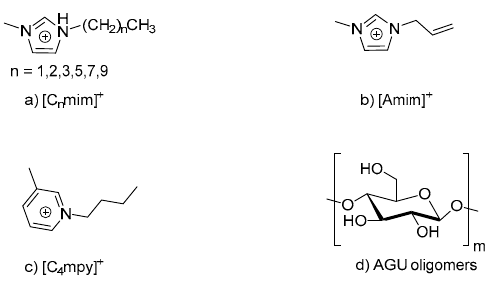
Figure 3. Structures for the ILs: ( a ) 1-alkyl-3-methyl imidazolium, ( b ) 1-allyl-3-methyl imidazolium chloride, ( c ) 1-butyl-3-methyl pyridinium chloride, and ( d ) β -anhydroglucopyranose (AGU) oligomers with a degree of polymerization of 10.